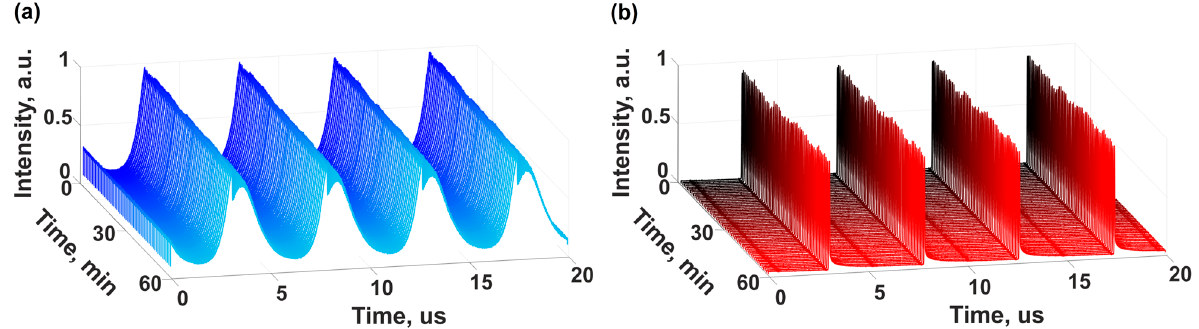
Figure 8. Series of time traces acquired with 1 min intervals during an hour for the pulse trains obtained at the fundamental ( a ) and Stokes ( b ) wavelengths upon a quasi-synchronous pumping with the modulation frequency of 208.8 kHz.